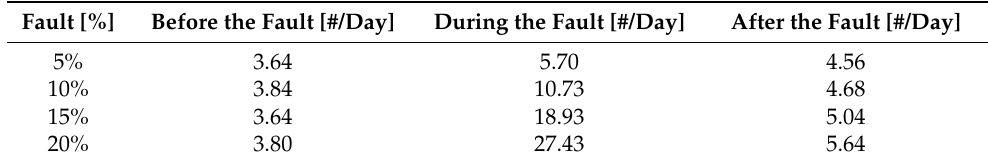
Figure 12. Real, measured, and estimated values of the state variable X 1 by the 5% fault. The value of the 5% fault is 330 mg MLSS/L. T = 8000. Table 5. Average number of resamplings per day by different values of the faults in case of the IPF. T =